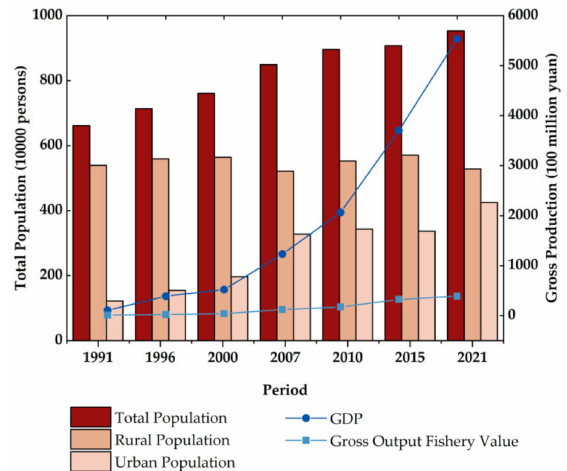
Figure 10. Population and socioeconomic development dynamics of the Hainan Island during